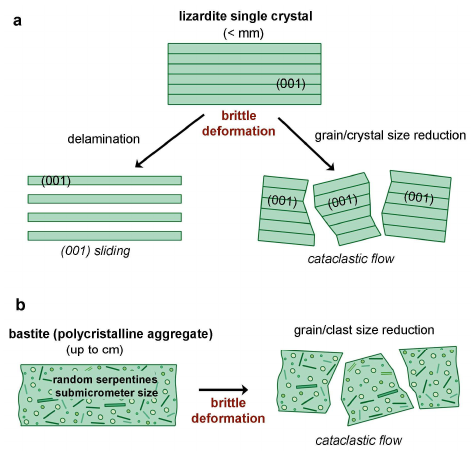
Figure 1. The effects of brittle deformation in: ( a ) serpentine single crystal (lizardite); and ( b ) serpentine polycrystalline aggregate (e.g., a bastitic lamella). (001) delamination favours easy (001) sliding in foliated lizardite-rich serpentinite, whereas grain-, crystal- or clast-size reduction favours cataclastic flow.